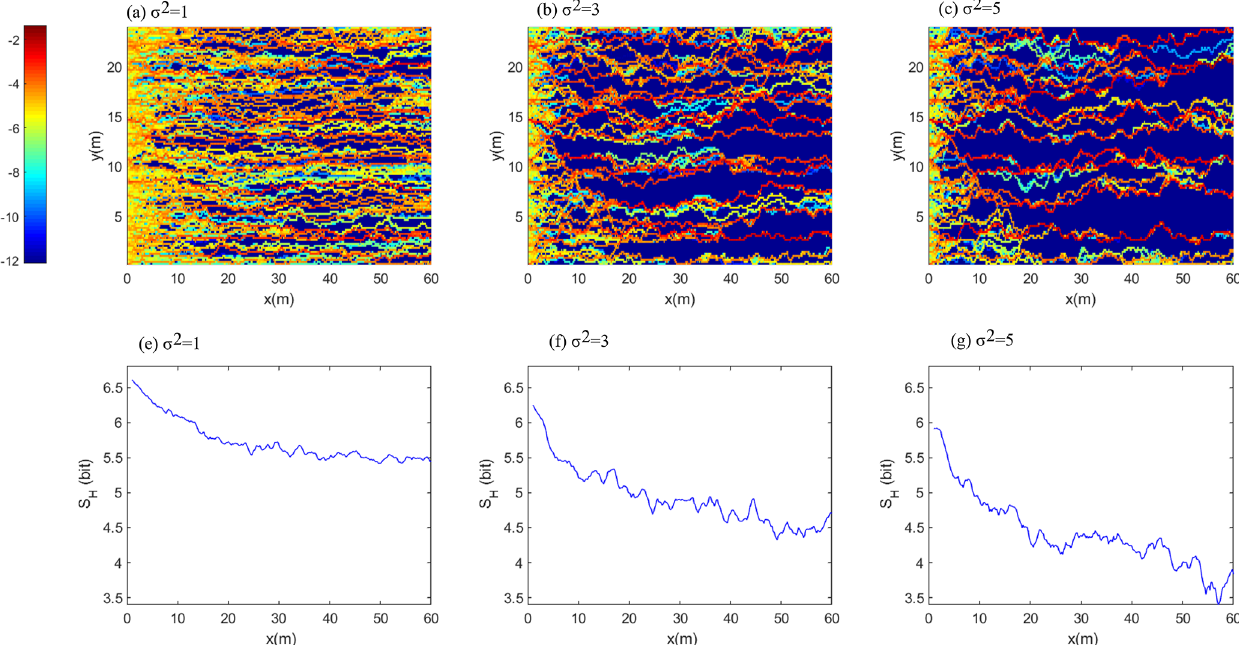
Figure 2. Accumulated, normalized number of particles that passed a distinct point in the domain as a function of the variance in ln( K ), σ 2 , (a, b, c) and the corresponding Shannon entropy of the transversal concentration, S H , as a function of the main flow direction (d, e, f) .